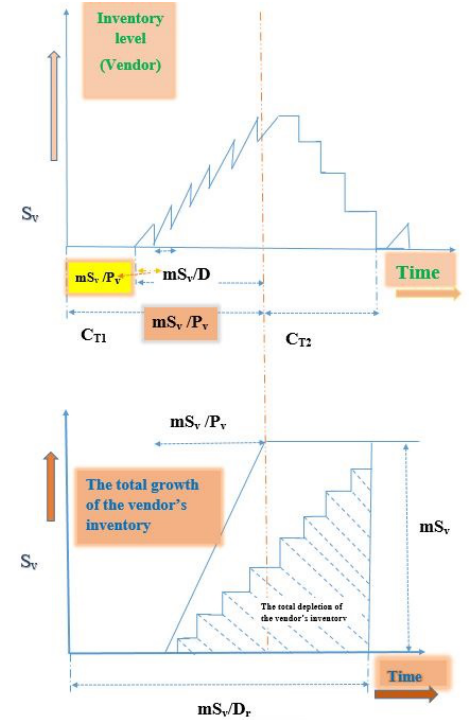
Figure 2. Inventory position for the